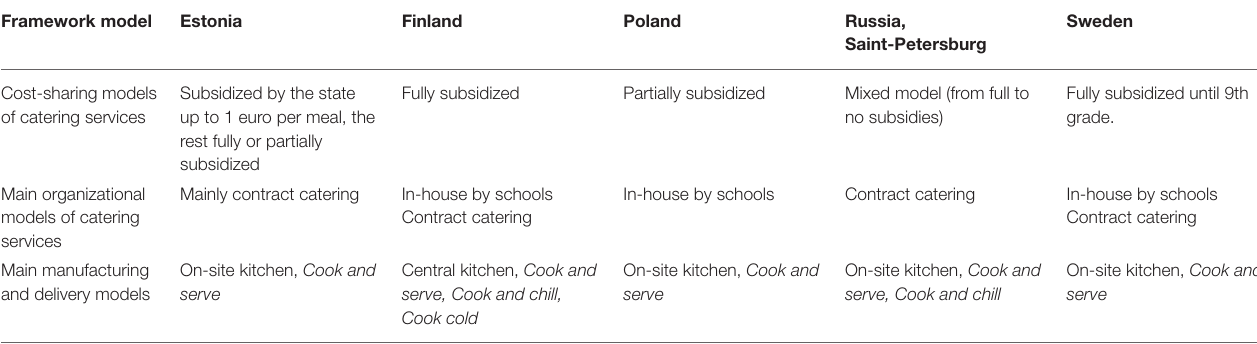
TABLE 1 | The school meal framework in selected BSR